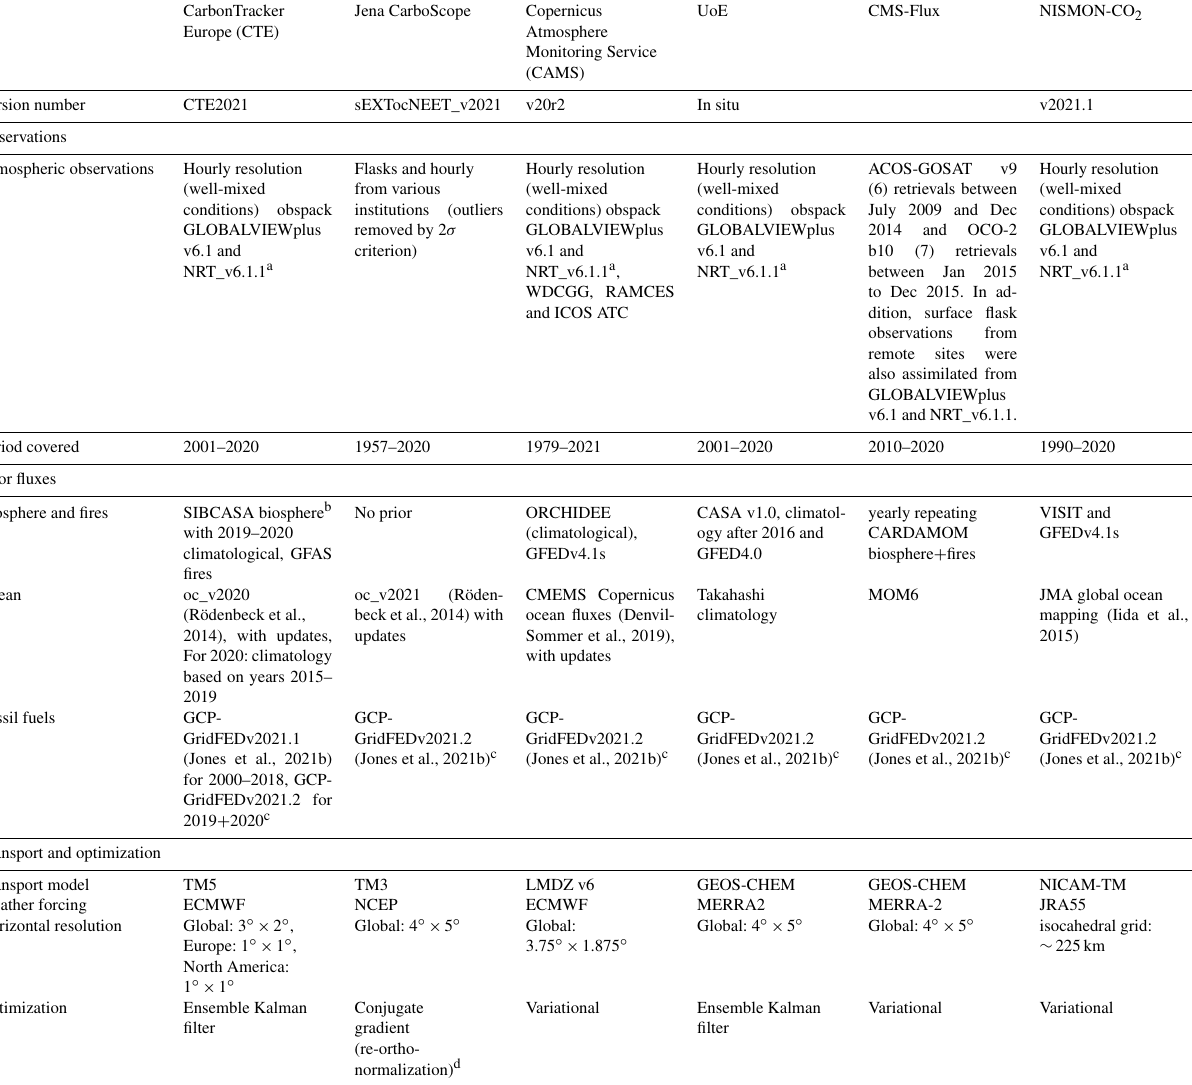
Table A4. Comparison of the inversion set-up and input fields for the atmospheric inversions. Atmospheric inversions include the full CO 2 fluxes, including the anthropogenic and pre-industrial fluxes. Hence they need to be adjusted for the pre-industrial flux of CO 2 from the land to the ocean that is part of the natural carbon cycle before they can be compared with S OCEAN and S LAND from process models. See Table 4 for